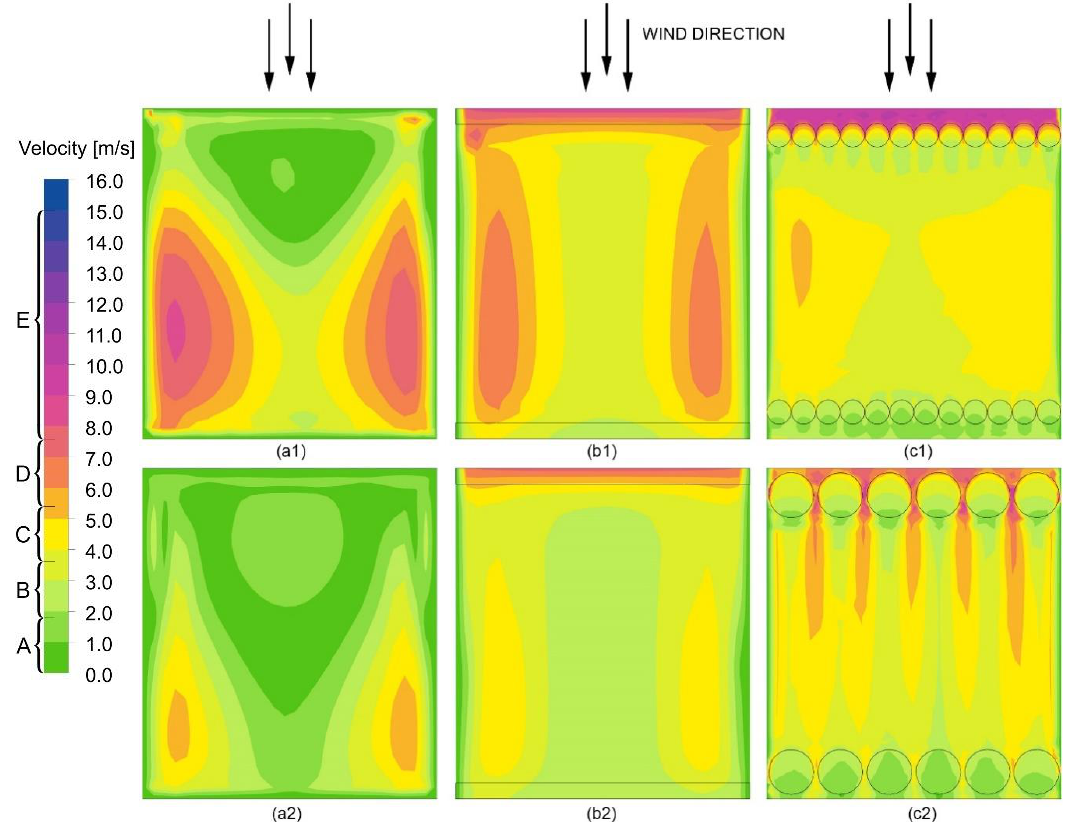
Figure 12. Wind velocity contour in the skygarden captured at 1.4 m above the skygarden plane, corresponding to occupants’ height with ( a1 ) 1.5 m railing, ( a2 ) 2 m railing, ( b1 ) 1.5 m hedge, ( b2 ) 2 m hedge, ( c1 ) 2.5 m trees, and ( c2 ) 5 m trees. Table 5. Average wind speed in the skygarden at occupants’ height, (base) base configuration, (a1) 1.5